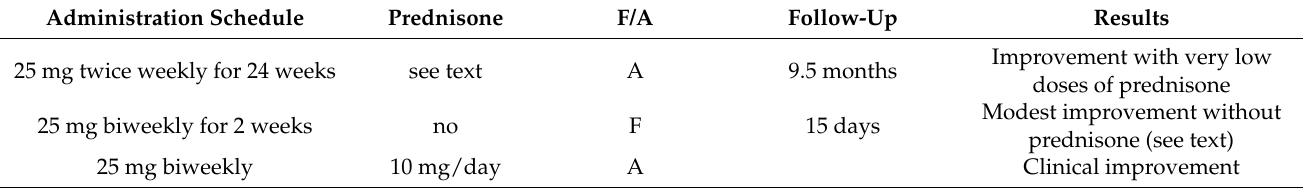
Table 4. Etanercept in patients with PMR: admisistration schedules, follow-up and